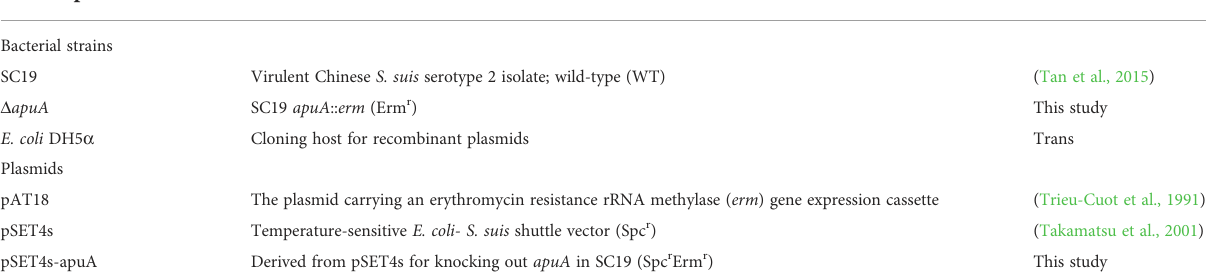
TABLE 1 Bacterial strains and plasmids used in this